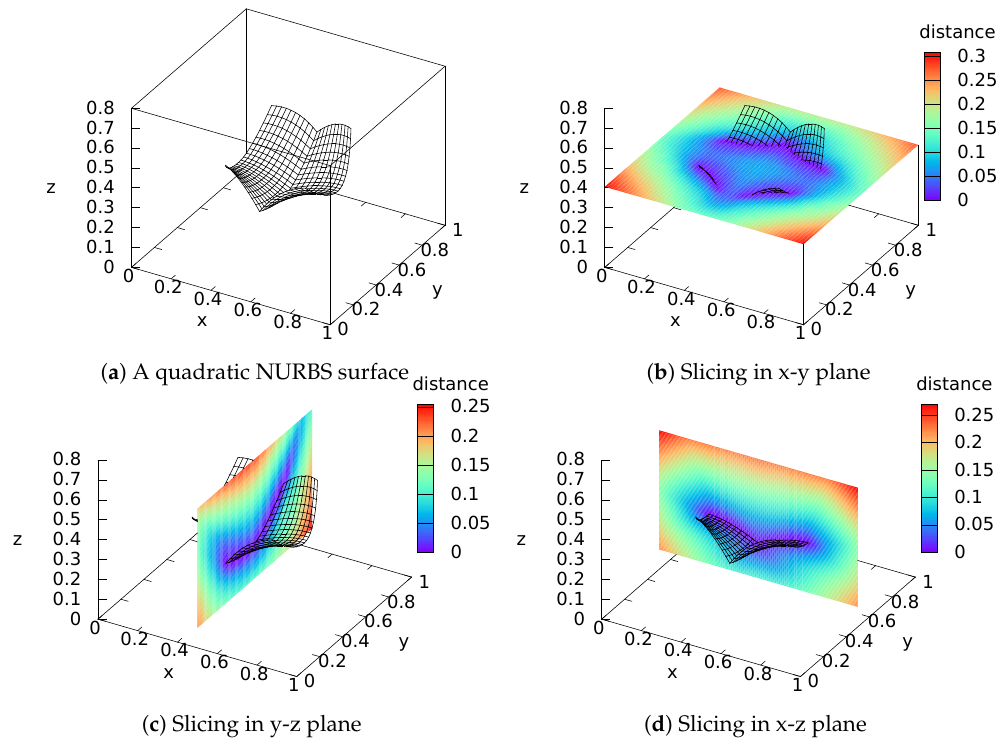
Figure 7. Algebraic level sets from a symmetric quadratic NURBS surface. ( a ) The valley of the surface contains only a G 0 continuity across the plane of symmetry. The level sets are plotted over three principal planes slicing the surface: ( b ) x-y plane; ( c ) y-z plane; and ( d ) x-z plane.